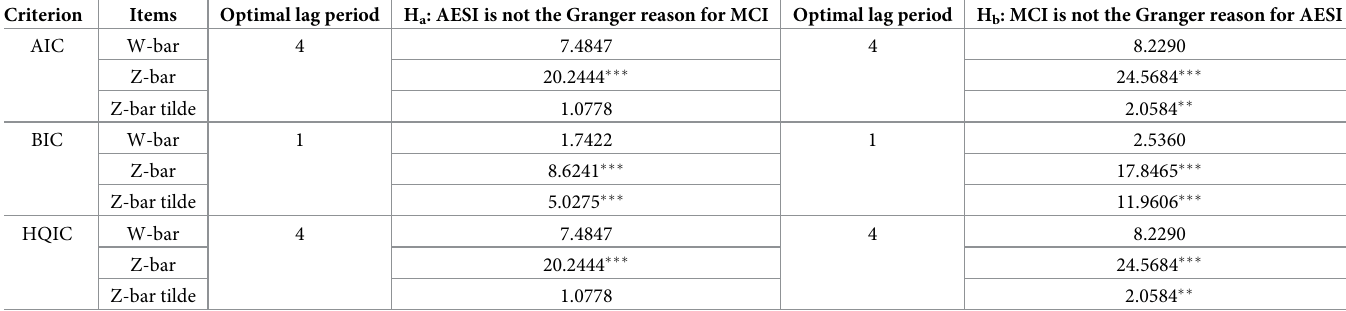
Table 4. Results of the panel Granger causality test (PGCT) between average export similarity index (AESI) and market concentration index (MCI). Criterion